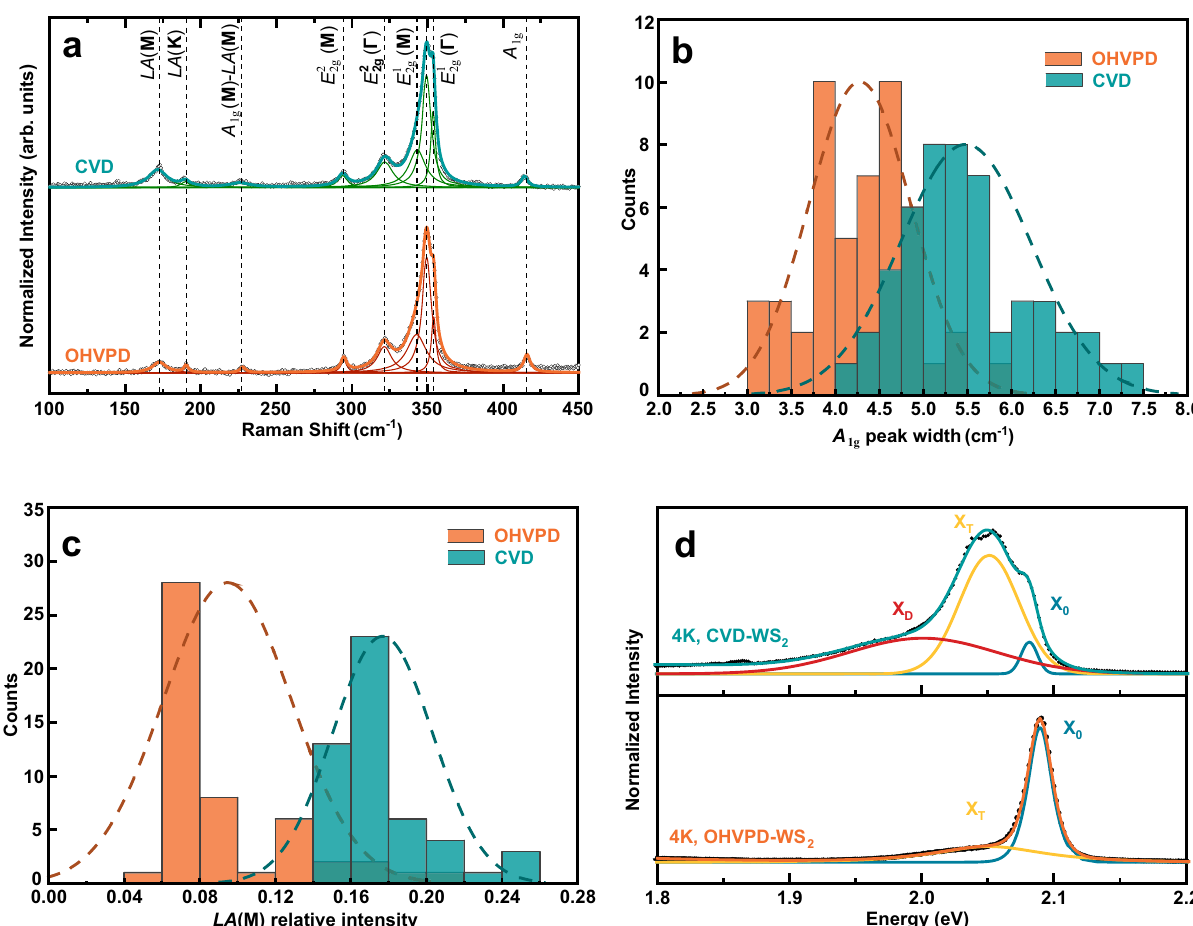
Fig. 2 Optical characterizations of OHVPD- and CVD-WS 2 monolayers. a Typical Raman spectra showing the characteristic modes of OHVPD- and CVD- WS 2 monolayers excited by 532 nm wavelengths. The hollow circles and coloured lines are the experimental and Lorentzian fi t curves respectively. b , c Statistic distribution of out-of-plane mode A 1g Raman peak width and normalized intensity of longitudinal acoustic at M point in the Brillouin zone LA ( M ) Raman peak for OHVPD- and CVD-WS 2 monolayers. The dashed lines represent the normal distribution curves. d Low-temperature PL spectra of OHVPD- and CVD- WS 2 monolayers at 4 K. The solid lines and dashed ones are the experimental and fi tted peaks respectively. The fi tted peaks can be assigned to neutral exciton (X 0 ), trion (X T ), and defect-bound exciton (X D